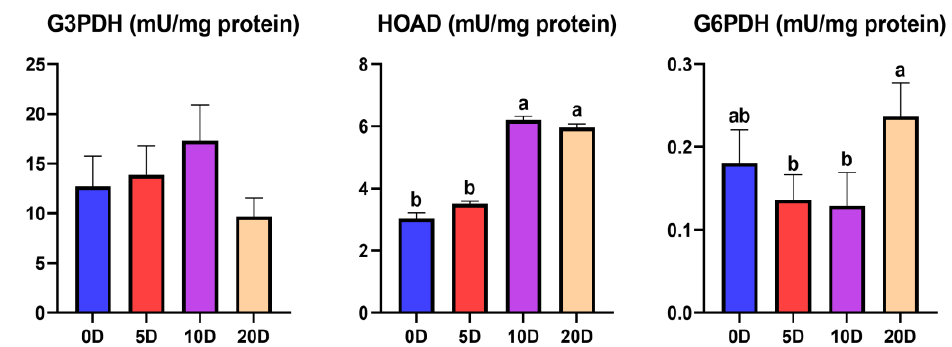
Figure 3. Means ± SEM of the enzyme activities ( n = 18 per treatment) related to lipid metabolism in the muscle. a, b Different letters indicate significant differences between the pre-slaughter times ( p < 0.05). G3PDH: glyceraldehyde-3-phosphate dehydrogenase; HOAD: β-hydroxyacyl CoA dehydrogenase; G6PDH: glucose 6-phosphate dehydrogenase. Transformation data for the parameters when performing analysis of variance: G6PDH (square root); HOAD (log10). In transformed variables, the SEM are presented for the transformed data and means are presented as back-transformed for better interpretation.